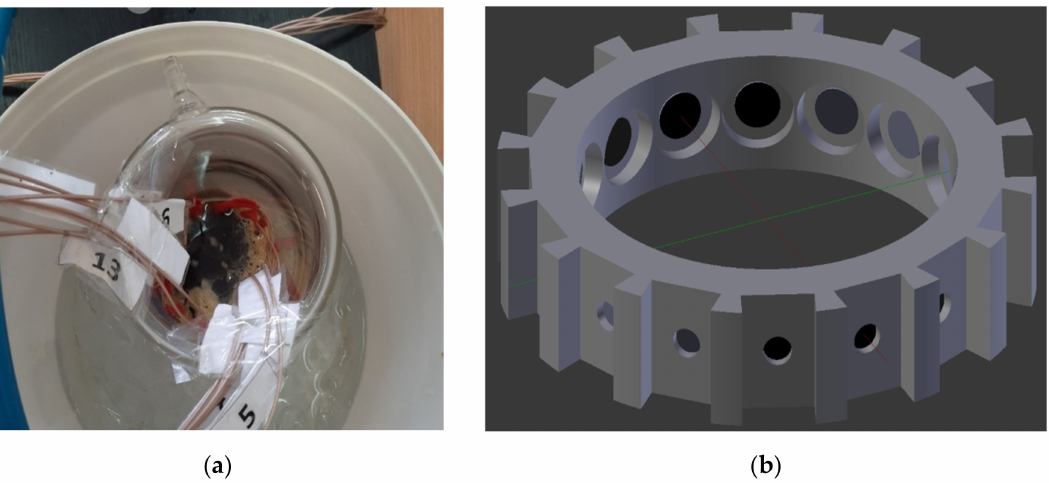
Figure 4. ( a ) Jacketed beaker with supersaturated sucrose solution inside the ice bath (coaxial cables are numbered from 1 to 16); ( b ) 3D printed sensor insert, to mount the ERT